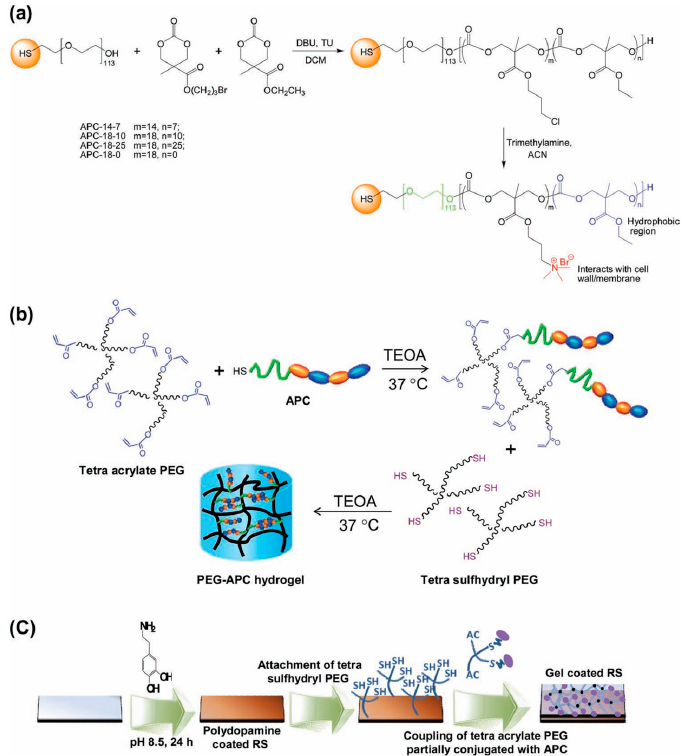
Figure 13. Synthetic scheme for the fabrication of ( a ) aminated polycarbonates (APCs); ( b ) PEG-APC hydrogel; and ( c ) hydrogel coating onto silicone rubber surface. Reproduced with permission from [39]. TEOA: triethanolamine. RS: Silicon rubber.